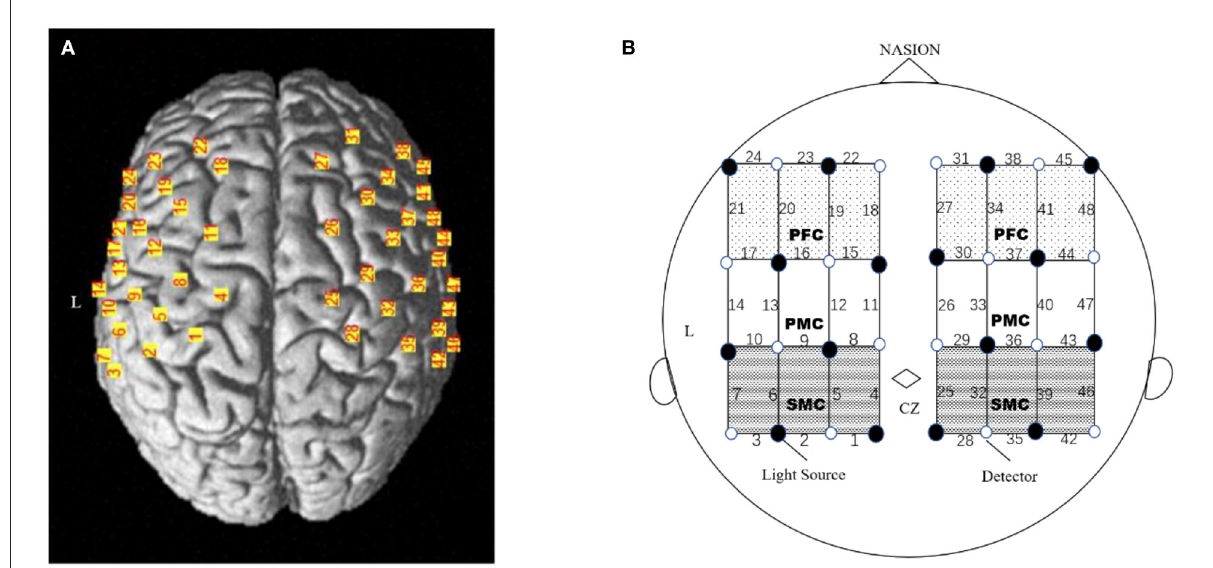
FIGURE2 Experimental setting of the optodes. (A) 3D location of the optodes exposed to the brain surface of a standard brain. A total of 32 optodes. (B) The channels covering the SMC, PMC and PFC, comprising 8 light source fibers (black dot) and 8 detectors (white dot), were arranged on the scalp to enable 48 channel measurements. The Cz position of the international 10–20 system was the marker for ensuring the replicable placement of the optodes.